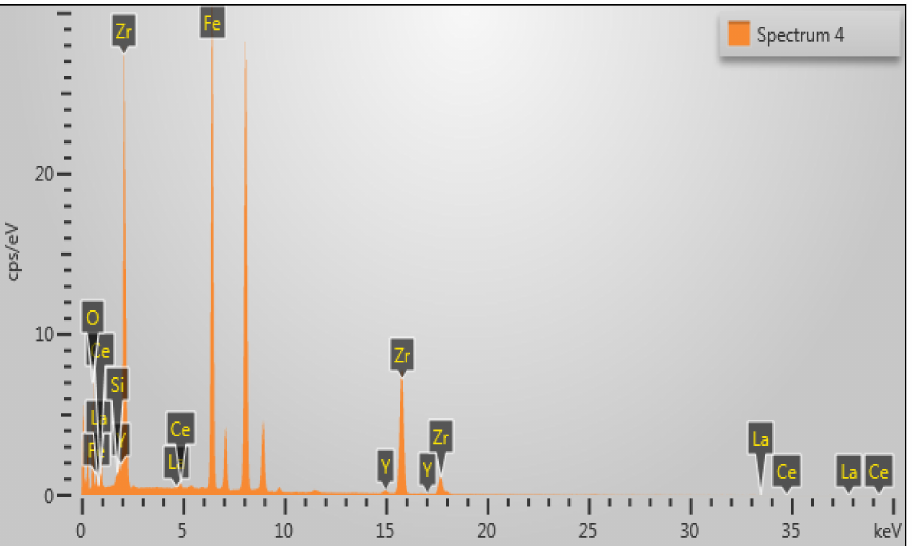
Figure 6. Energy Dispersive spectroscopy (EDS) patterns for Fe 3 O 4 @mZrO 2 -Re (Re =